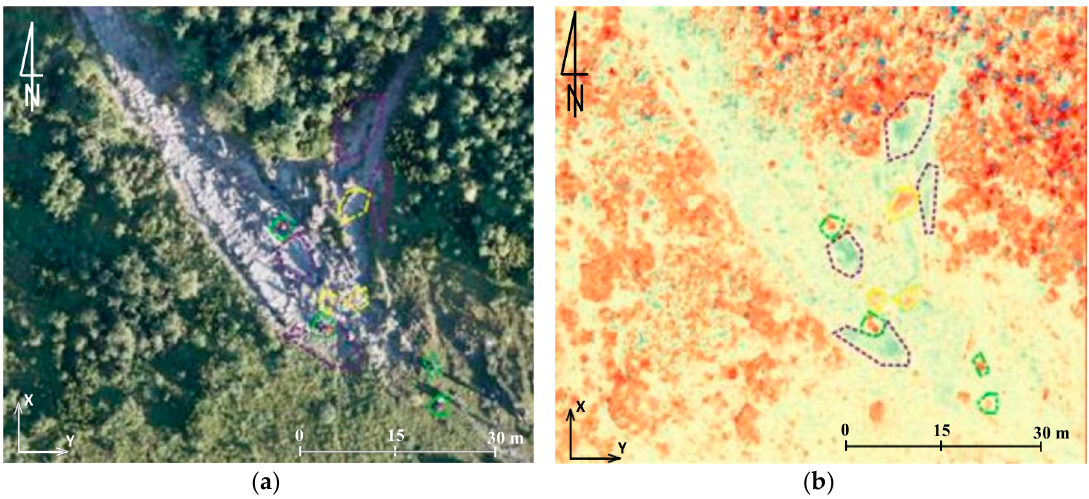
Figure 16. Field A: ( a ) ortophotomap, and ( b ) the results of comparison of DSM UAV–DSM ALS (source: authors’ own study).